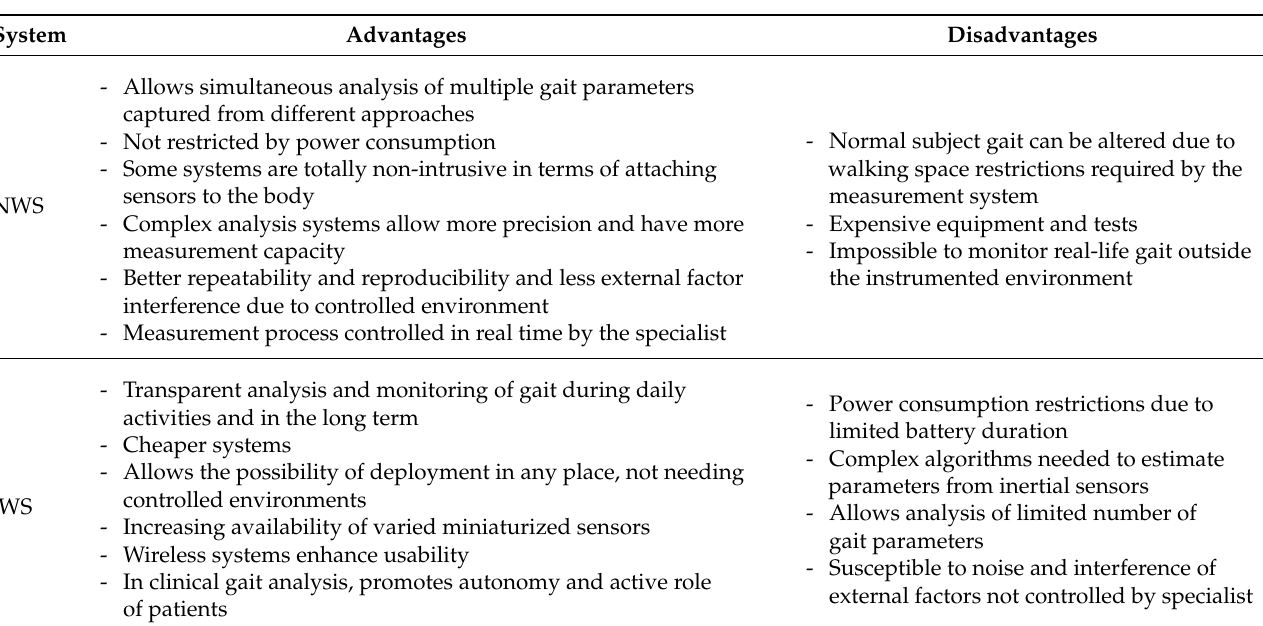
Table 2. Non-wearable system (NWS) and wearable system (WS) comparison